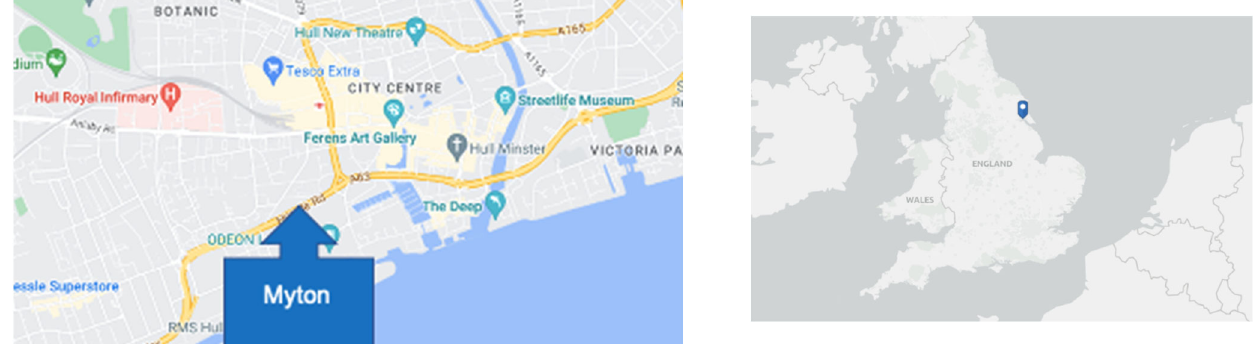
Figure 1. Sampling site location in Kingston-upon-Hull, UK. Latitude 53.739415, Longitude -0.34786742.